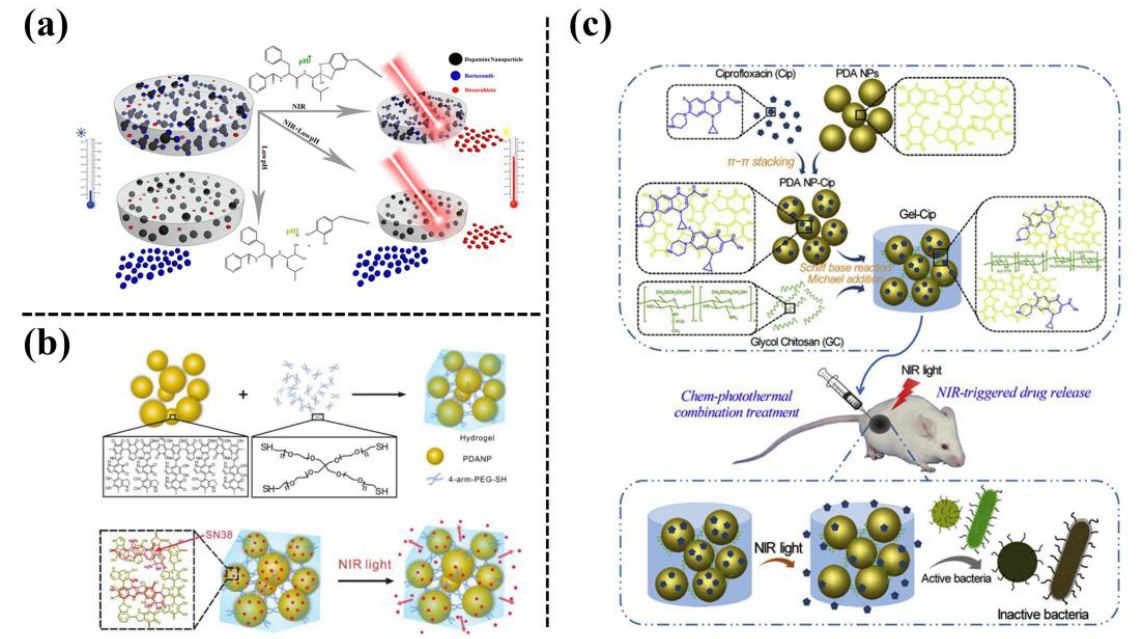
Figure 9. ( a ) Schematic of a multi-stimulus responsive mussel-inspired hybrid hydrogel as a single platform for synergistic anticancer treatment by combining PTT and multidrug chemotherapy [69]. ( b ) Preparation of an NIR-responsive hydrogel by using PDA-NPs as a crosslinking agent to crosslink 4-arm-PEG-SH to realize NIR-triggered drug release [70]. ( c ) Preparation of an NIR light-triggerable thermo-sensitive hydrogel by mixing ciprofloxacin (Cip)-loaded PDA-NPs with glycol chitosan (GC) [71].